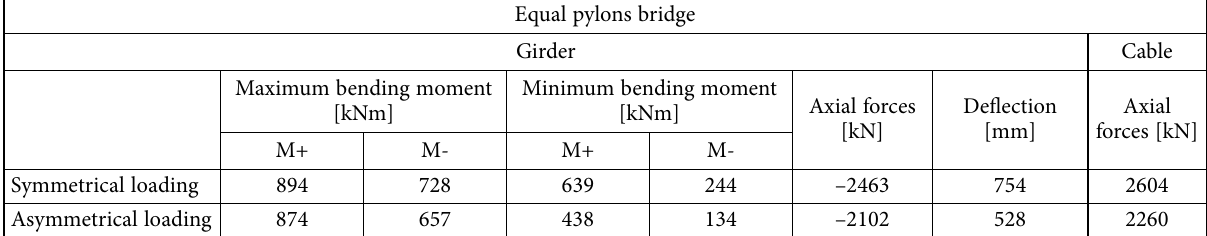
Table 2. Equal pylons bridge elements